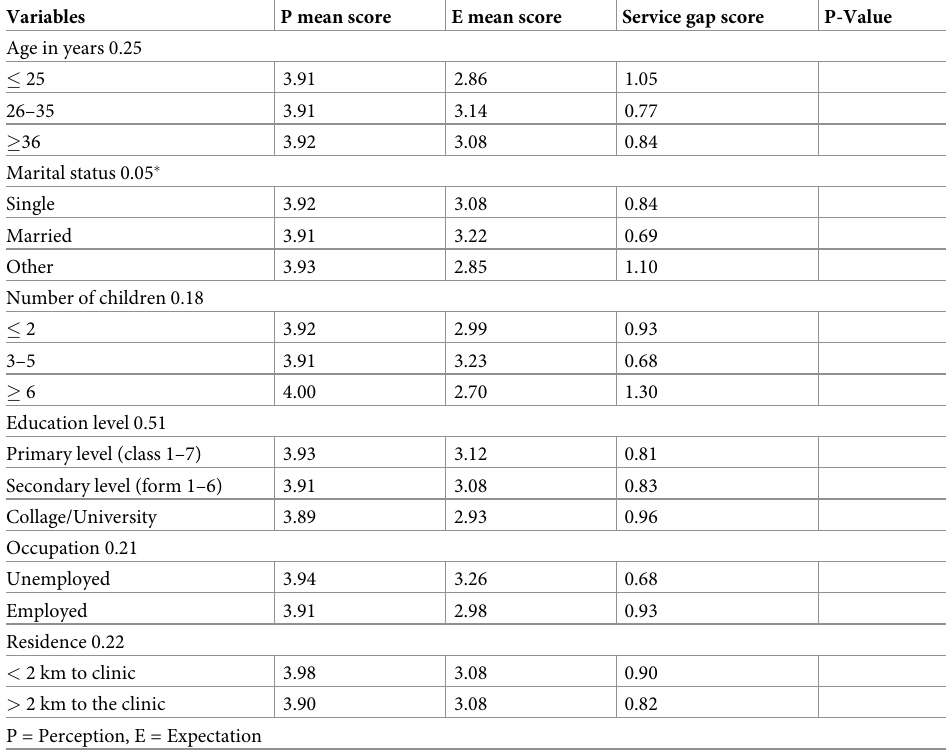
Table 4. Association of pregnant women service gap scores and socio-demographic characteristics (n = 105).